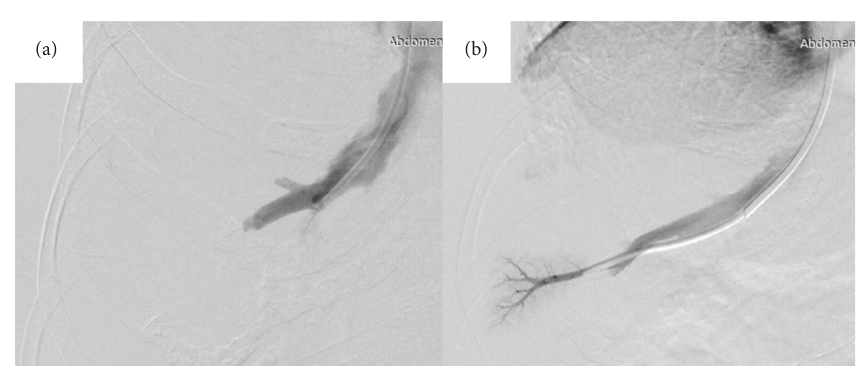
Figure 1: Transjugular liver biopsy was performed under X-ray fluoroscopy guidance. (a) A venogram showing a 5-Fr catheter inserted into the right hepatic vein. (b) A postbiopsy venogram, showing no leakage of contrast agent to the outside of the liver.